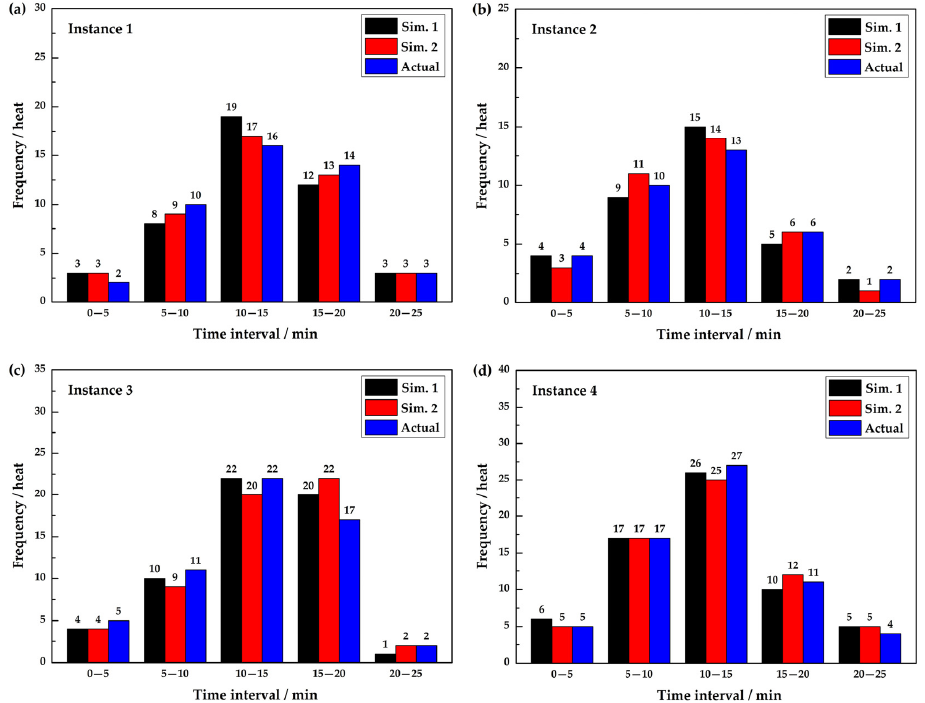
Figure 11. Distributions on the transfer times of heats from LF to CCM.